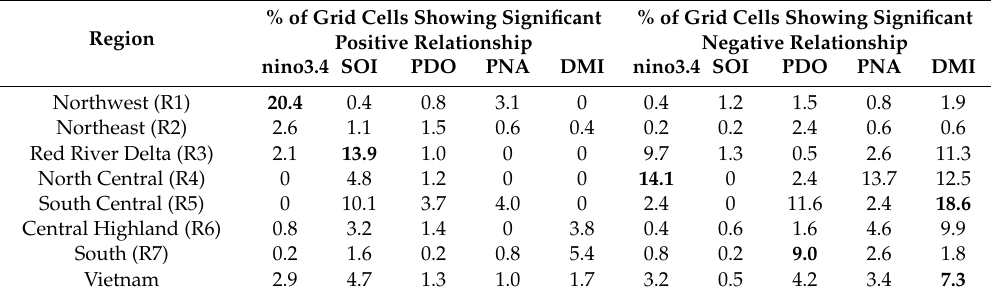
Figure 7. Maps showing the significant relationships between annual maxima precipitation and climate indices representing teleconnections: ( a ) nino34, ( b ) the Southern Oscillation Index (SOI), ( c ) the Pacific Decadal Oscillation (PDO) index, ( d ) the Pacific North American (PNA) Index, and ( e ) the Dipole Mode Index (DMI). Blue (red) pixels indicate a significant positive (negative) relationship at the 5% level. Seven climate regions are also shown (polygons bounded by black lines). Table 2. The percentage of grid cells showing a significant relationship (at the 5% level) between the magnitude of precipitation extremes and the five climate indices across the national and regional scale. Field significance of the relationship has been highlighted in